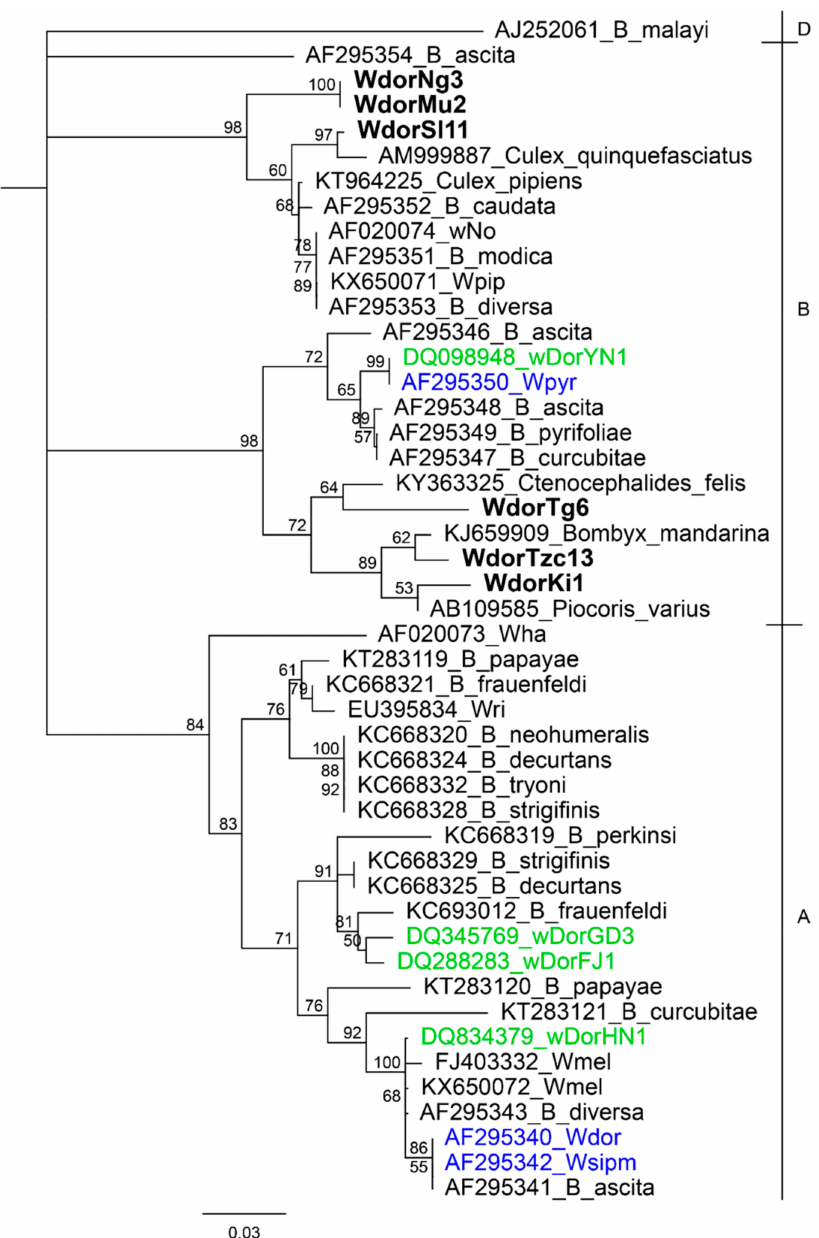
Figure 1. Neighbour joining tree based on Wolbachia surface protein ( wsp ) gene sequences of Wolbachia detected from B. dorsalis in this study (in bold), from B. dorsalis in China (labelled in blue), from B. dorsalis in Thailand (labelled in green) and from other Bactrocera species. Sequences from closest homology matches to Wolbachia detected in this study are also included. Other common Wolbachia strains (wMel, wRi, wHa, wNo and wPip) are also included. Wsp sequence from Wolbachia endosymbiont of Brugia malayi is included as an outgroup. Sequences are labelled with genbank accession numbers followed by strain name or host organism, or strain name for sequences from this study. Wolbachia super groups are indicated in higher case letters on the right. The detected Wolbachia are denoted by W followed by the host denoted as dor ( B. dorsalis ), population (Tg-Togo, Tzc-Tanzania, Ki-Kitui, Sl-Sri Lanka, Ng-Nguruman and Mu-Muranga) and population sample ID. Bootstrap values are indicated above branches. Branches with bootstrap support lower than 50% are